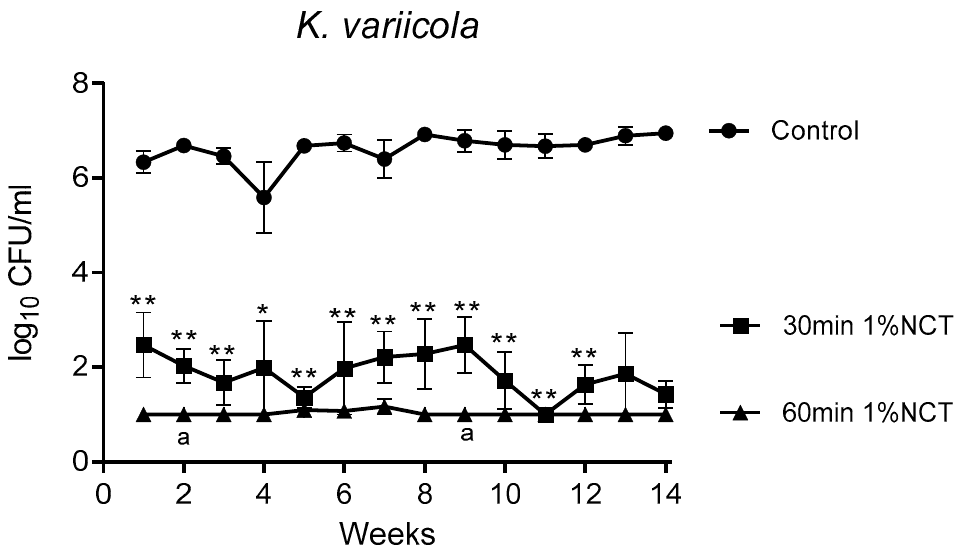
Figure 3. Bactericidal activity of 1% NCT at pH 7 and 37 °C against biofilms of K. variicola clinical isolate grown for 14 weeks. Weekly evaluation by quantitative killing assays. Mean values ± SEM, n = 5 ( n = 4 for weeks 12–14); p < 0.01 for all values of 30 min and 60 min NCT versus control except for p < 0.05 for 30 min NCT after 4 weeks; * p < 0.05 versus control; ** p < 0.01 versus control; a p < 0.05 of 30 min versus 60 min NCT.